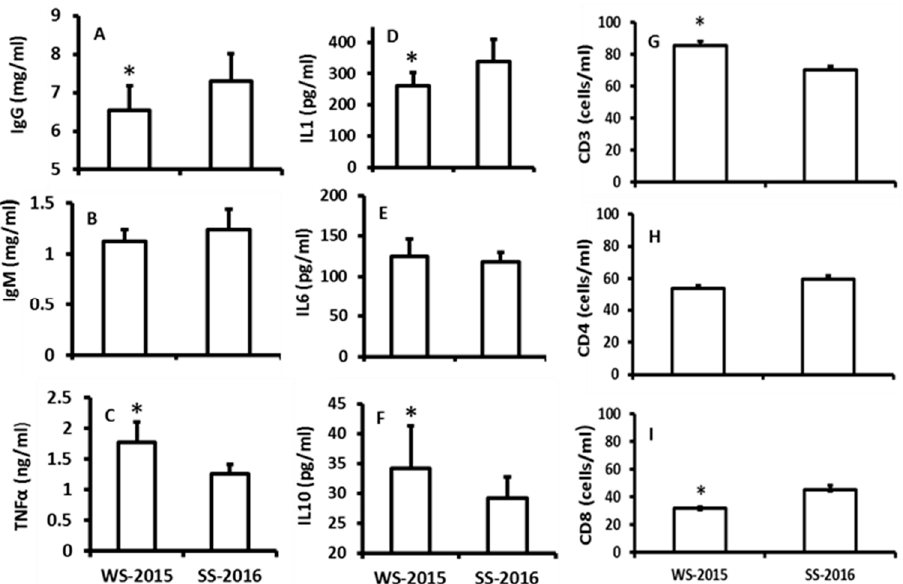
Figure 3. The effects of naturally seasonal alterations on the immuno-responses of hamsters. WS-2015: winter solstice of 2015; SS-2016: summer solstice of 2016. A , B and C : the levels of IgG, IgM and TNF α , respectively; D , E and F : the levels of IL1, 6 and 10, respectively; G , H and I : the numbers of CD3, 4 and 8, respectively. The data were expressed as means ± SDs of 16 hamsters each group. * Significant difference vs. SS-2016.